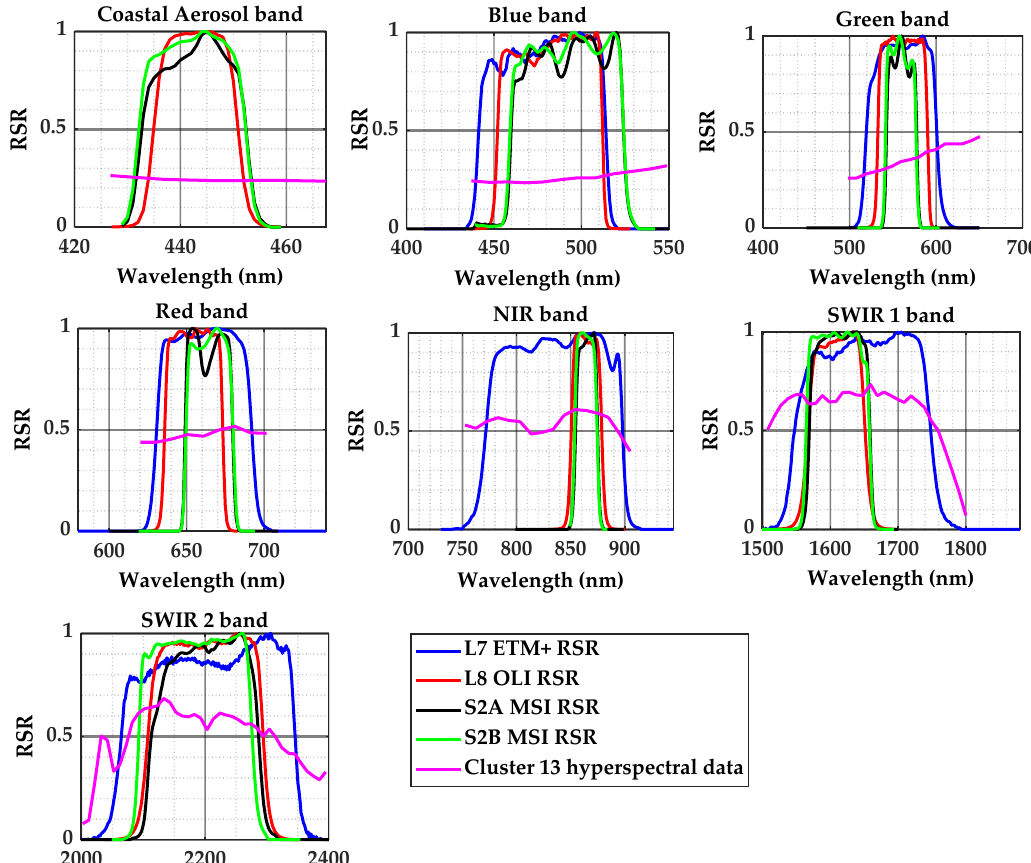
Figure 4. Relative Spectral Response (RSR) of Landsat 7 ETM+, Landsat 8 OLI, Sentinel 2A MSI, Sentinel 2B MSI and the derived hyperspectral profile of Cluster 13.